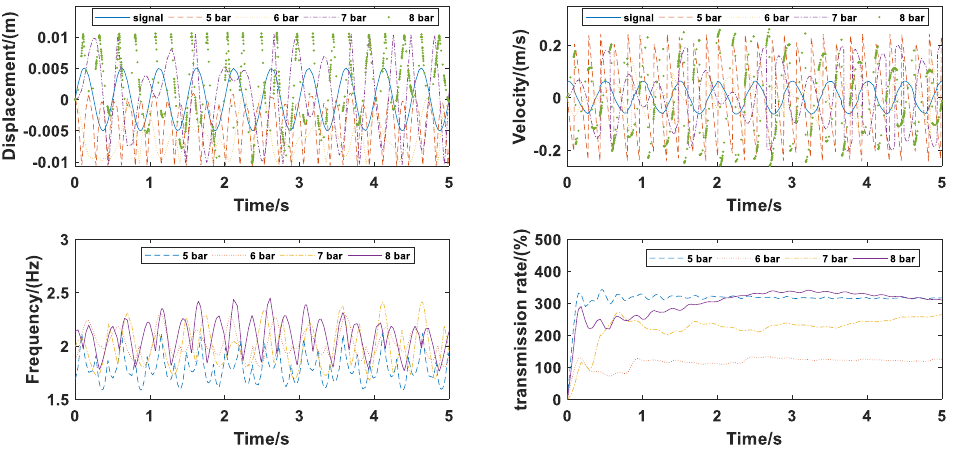
Figure 8. Simulation results under 2 Hz, with 5 mm amplitude vibration.